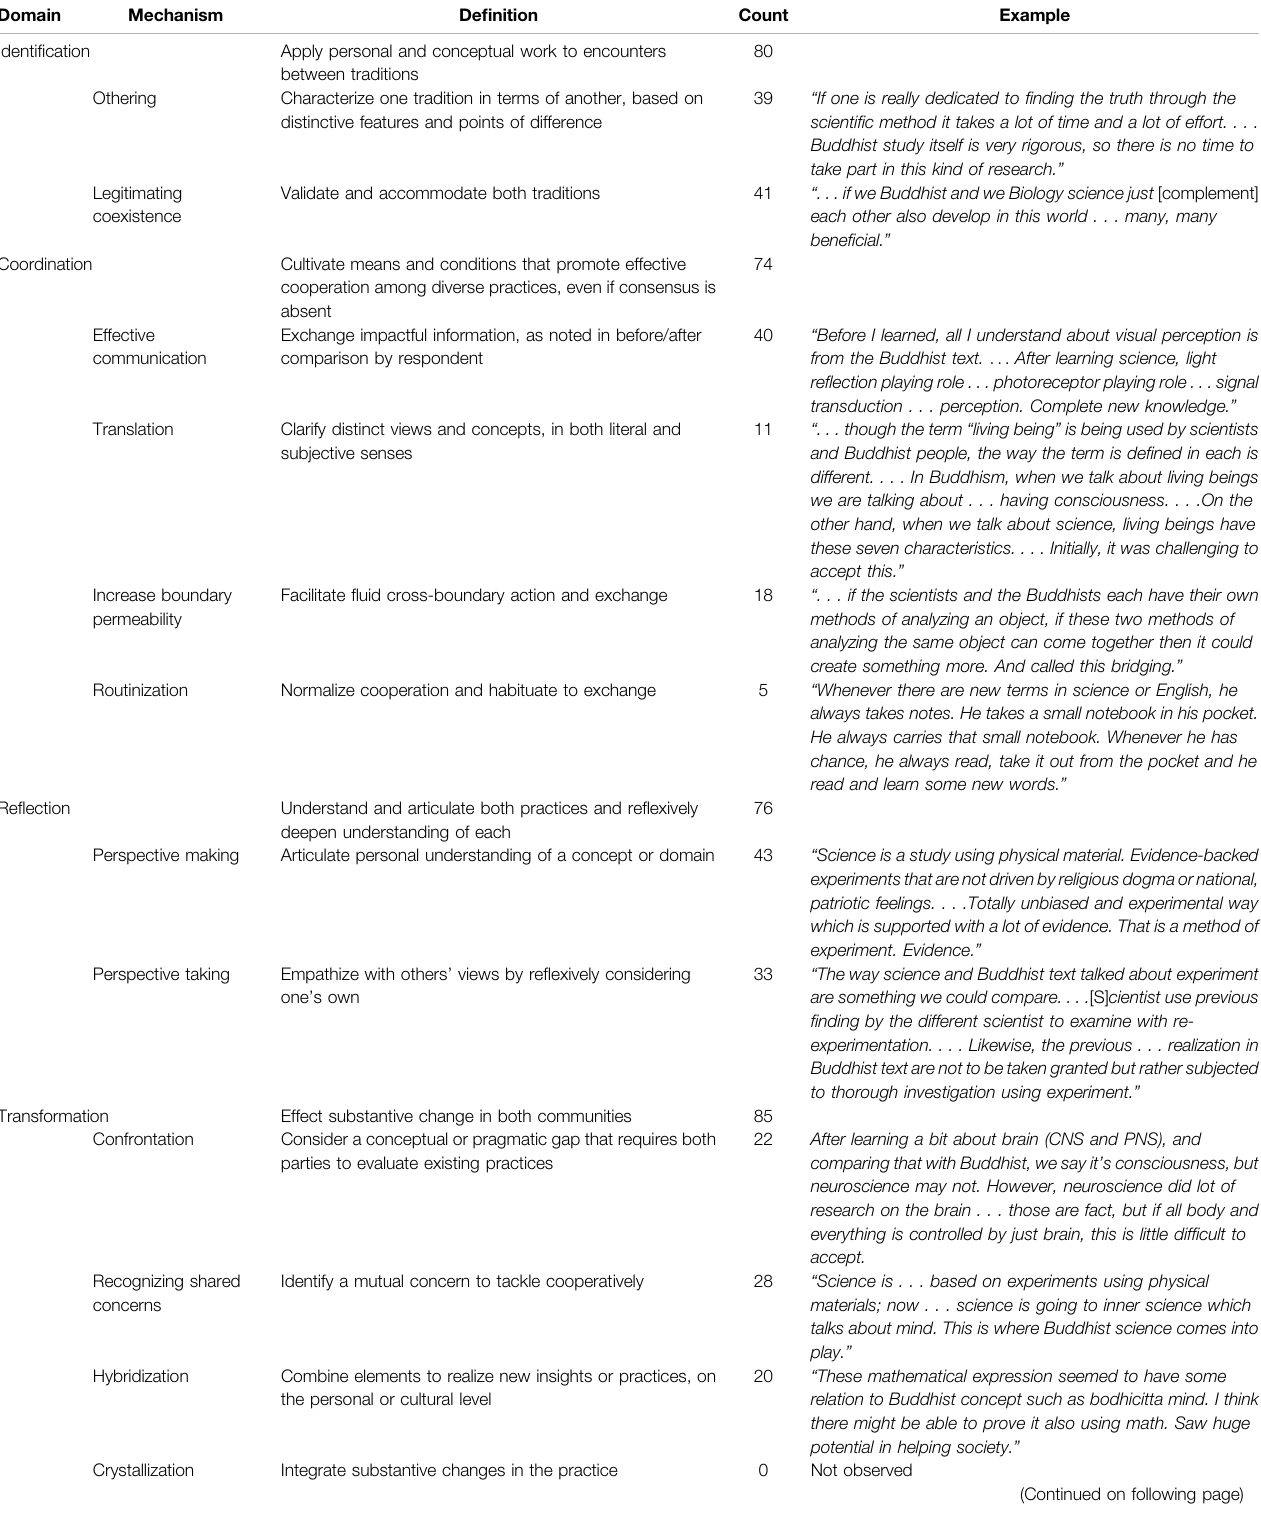
TABLE 2 | Domains and related mechanisms involved in boundary crossing between communities of practice. Domain frequencies represent a count of utterances that referenced any constituent mechanism in that category. Mechanism frequencies represent number of utterances referring to that mechanism. (respondent n = 15; utterances coded n =